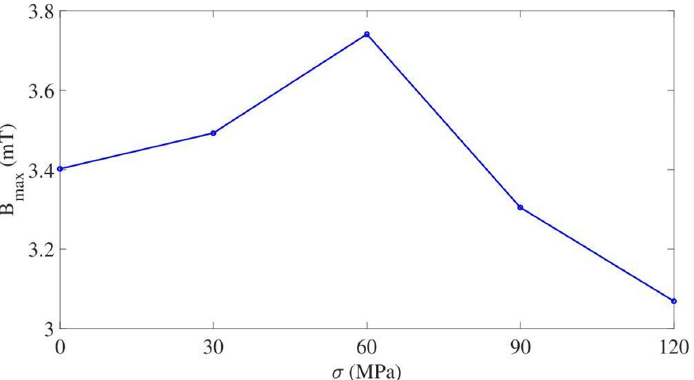
Figure 14. Maximum magnetic induction relative to stress for specimen 2 .